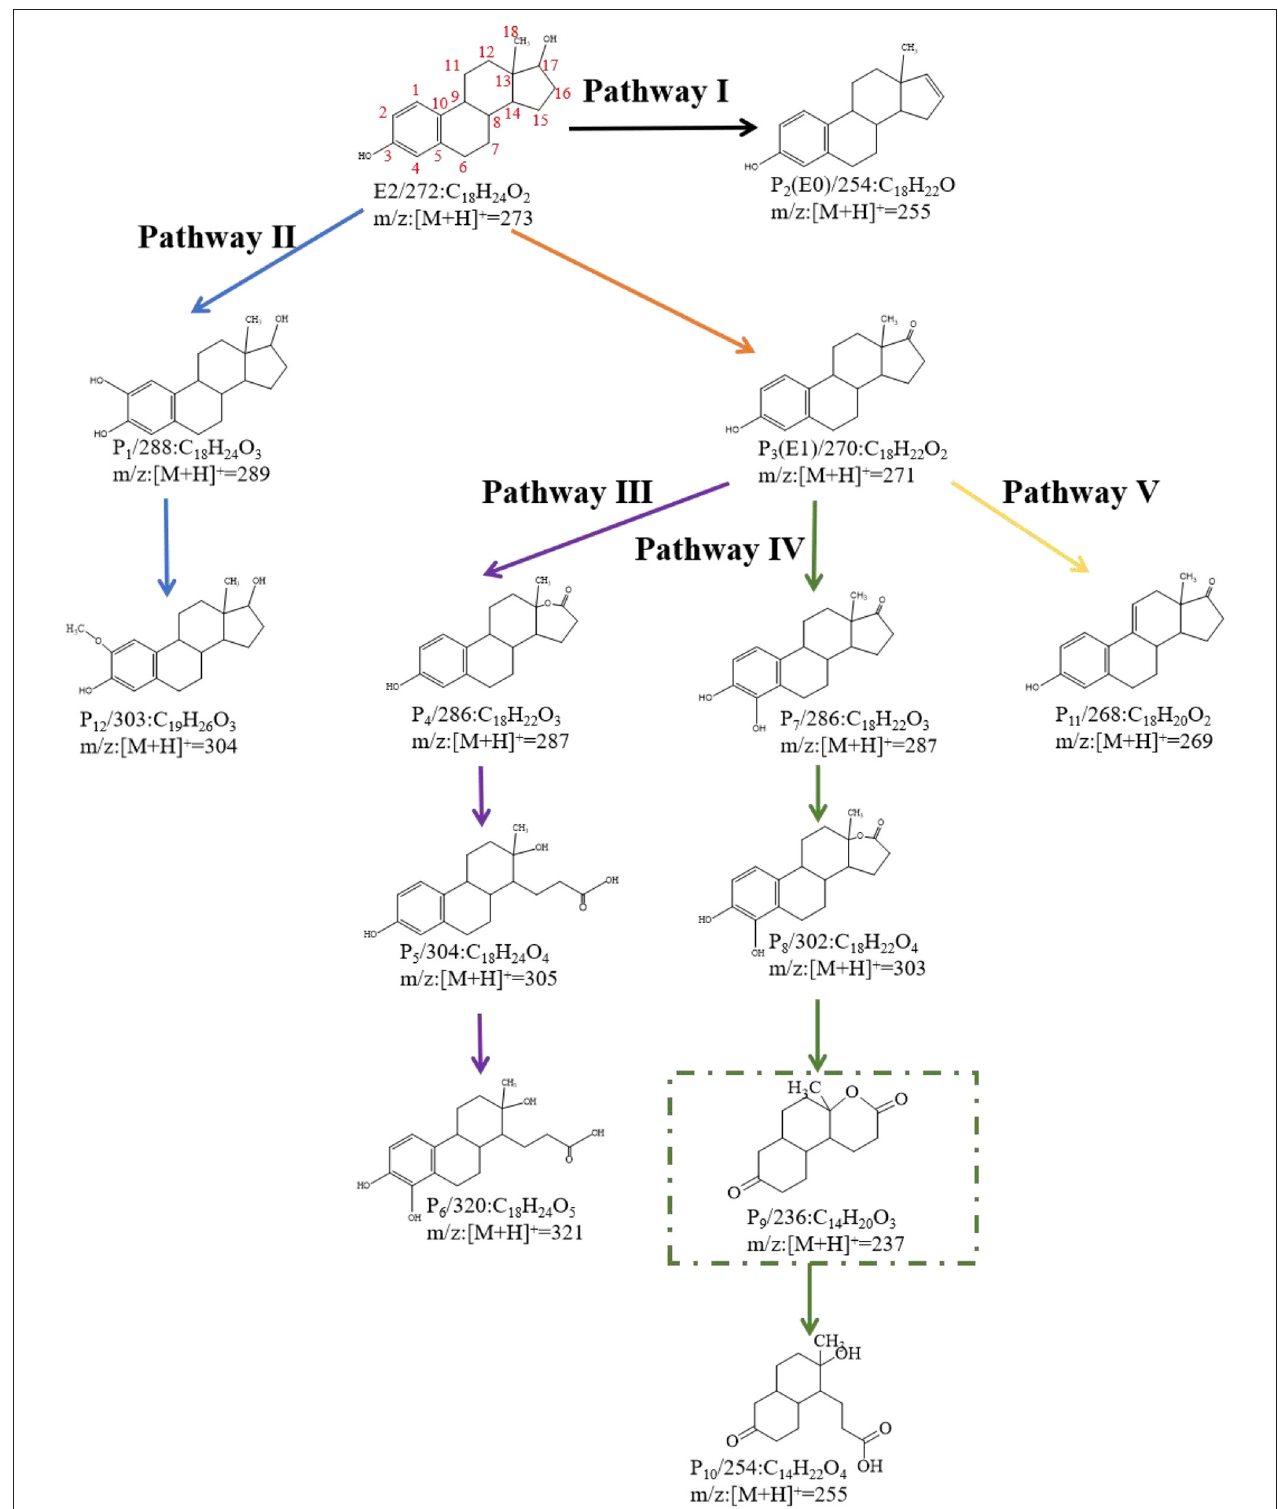
FIGURE 5 | E2 degradation products and predicted biodegradation pathways. The green rectangle indicated the metabolite that was not detected by liquid chromatography tandem mass spectrometry (LC-MS/MS) (the black, blue, purple, green, and yellow lines represent Pathway I, Pathway II, Pathway III, Pathway IV, and Pathway V,